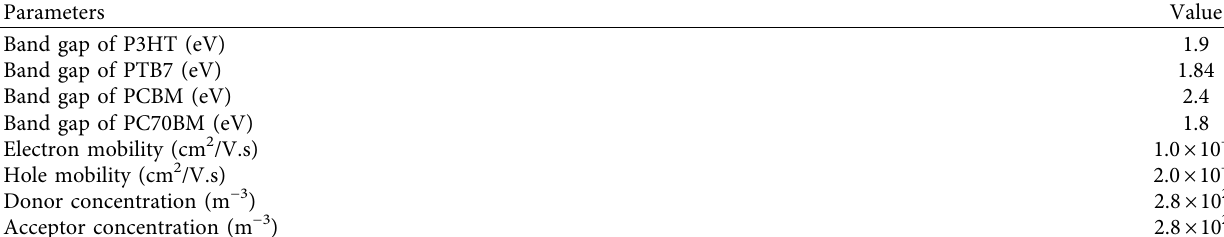
Table 1: Electrical parameters used for simulation